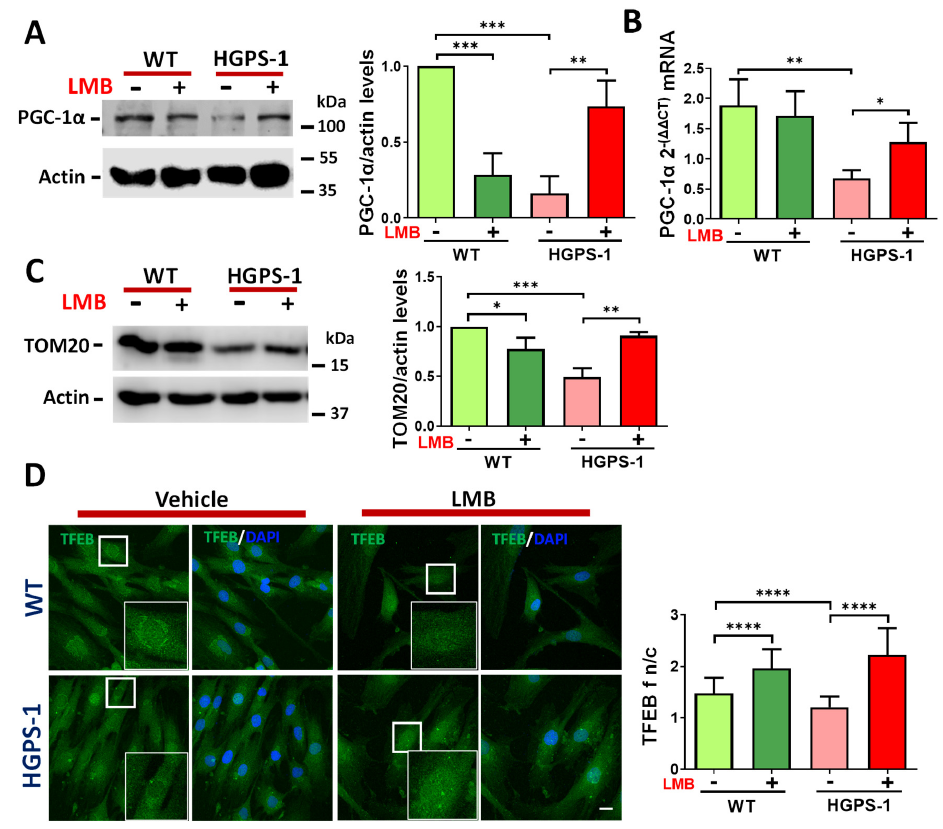
Figure 4. LMB treatment induces PGC-1 α expression in HGPS-1 fibroblasts. ( A ) Lysates from WT and HGPS-1 cell cultures treated with LMB or the vehicle alone for 3 days were fractionated by